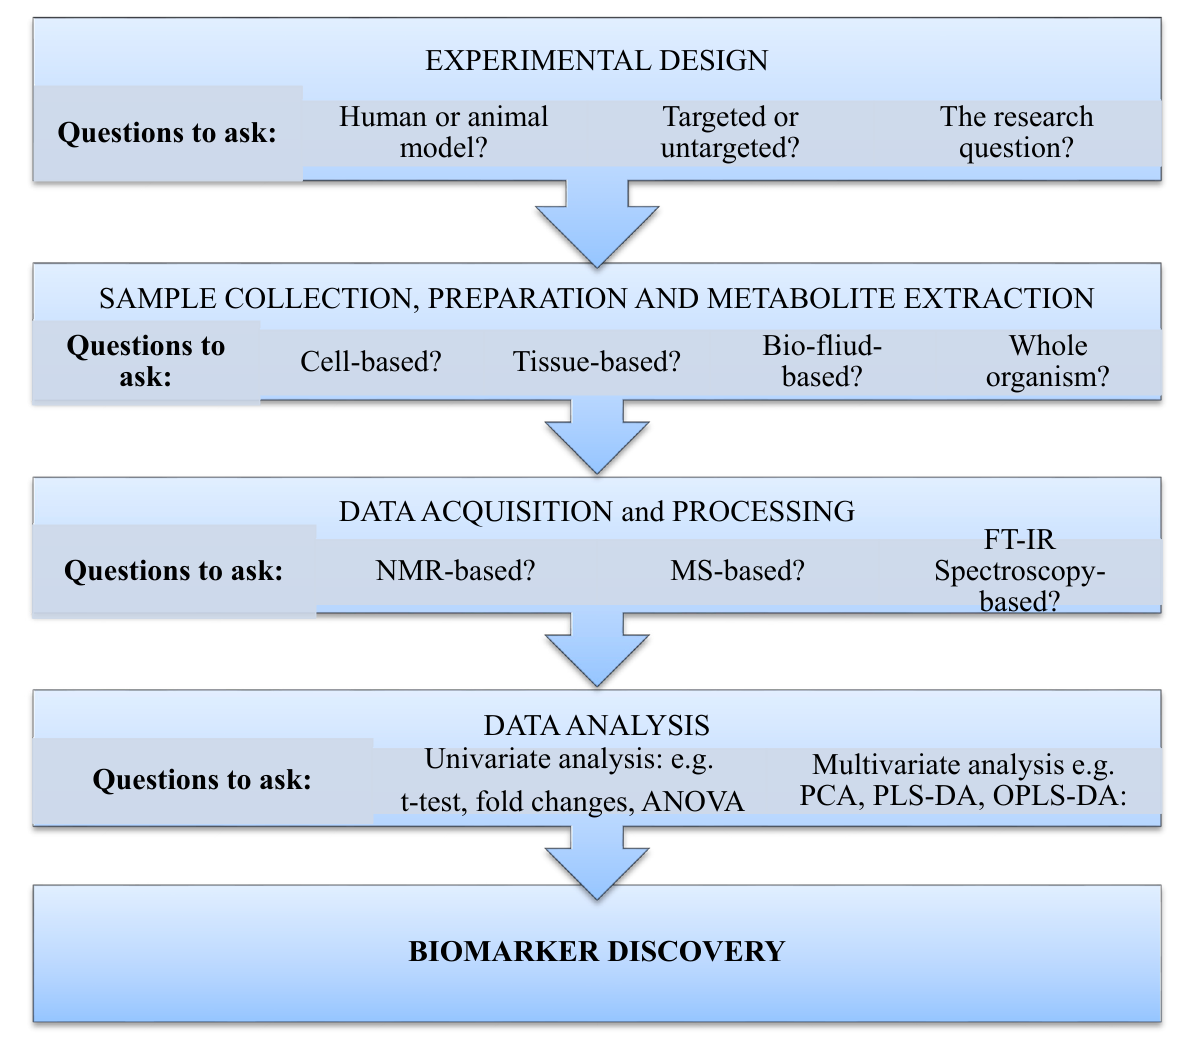
Figure 1. Metabolomic workflow. The first stage involves experimental design, followed by sample collection, preparation, and metabolite extraction. Next is acquisition and processing of data, then data analysis, and finally, making sense of the data through biomarker